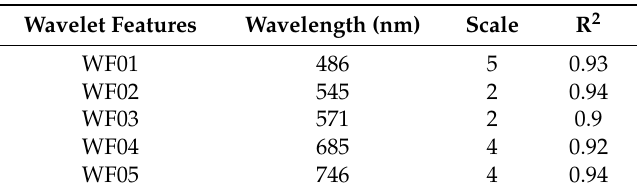
Table 3. Summary of central bands of wavelet features for rust infestation from the intersection of correlation scalograms of ASD and Headwall data.